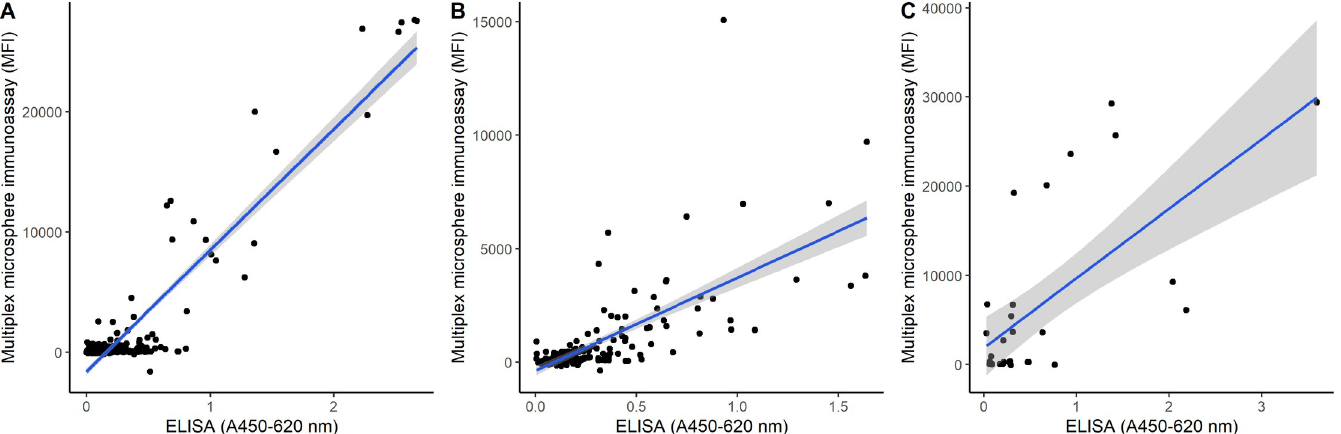
Fig 3. Correlation between MMIA results and commercially available or in-house ELISAs for EBOV (A), MARV (B) and CCHFV (C). For both the MMIA and the ELISAs results were obtained from 3 technical replicates for each sample and the average MFI value for each NP (EBOV, MARV or CCHFV) was then plotted against the average absorbance values obtained from the same sample in the corresponding ELISA. In (A) and (B) all serum samples from the Guinea panel and the validation panel were tested by in-house EBOV or MARV ELISAs, in (C) a subset of samples from the Guinea panel and validation panel were tested by commercial CCHFV IgG ELISA.